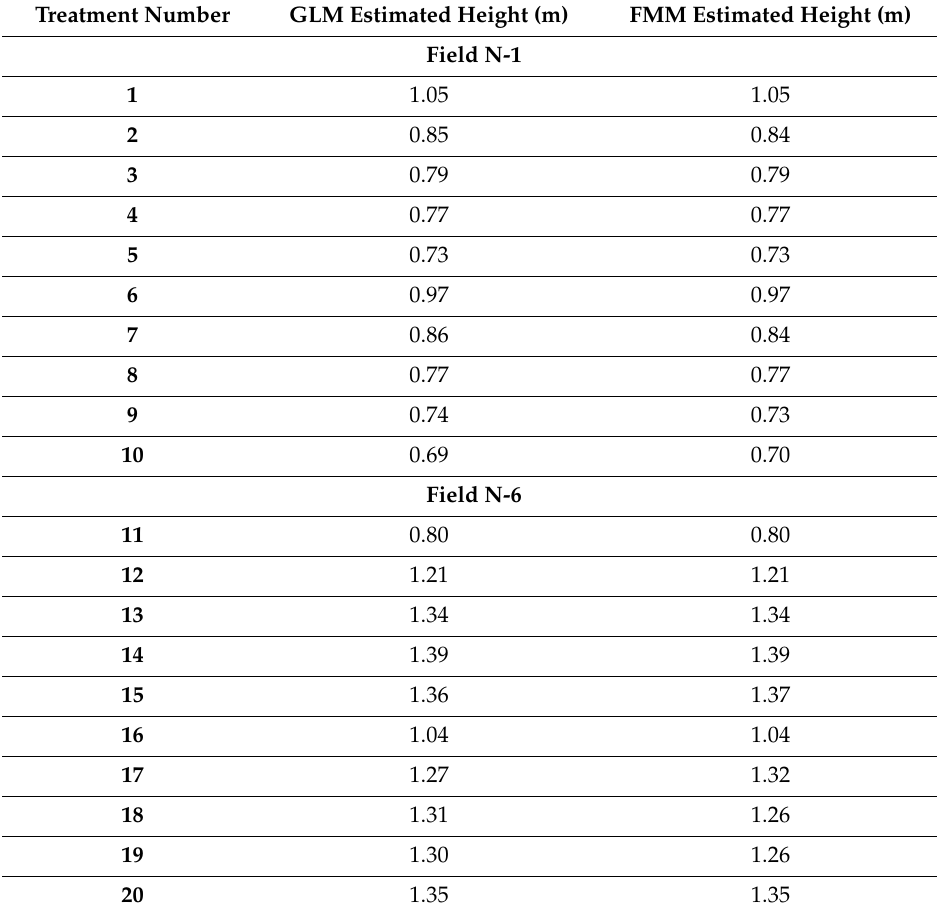
Table 1. Generalized linear model (GLM)-derived and finite mixture model (FMM)-derived height estimates of rice fields N-1 and N-6. The FMM height estimates were given 0.4 m of ground bu ff er on each side of the rice